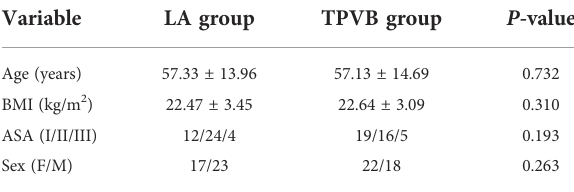
TABLE 1 Age, sex, BMI, and ASA classi fi cation of the